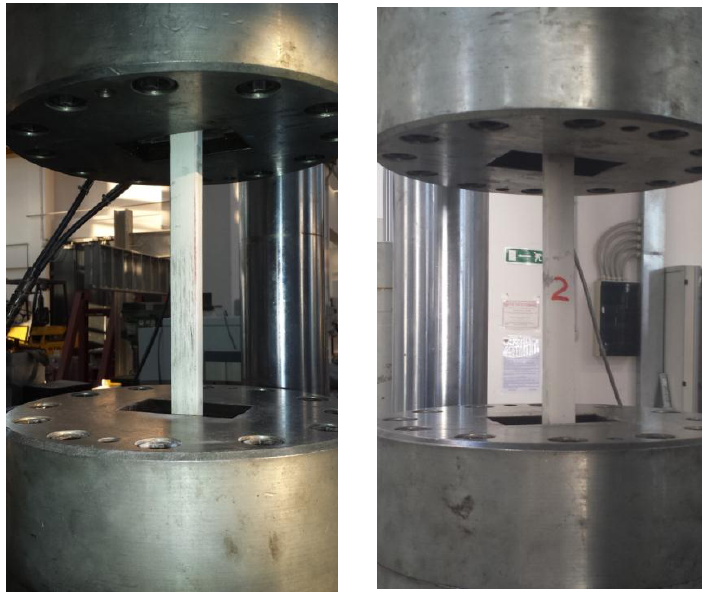
Figure 5. Preliminary tests on GFRP samples: Sample “1” ( left ) and Sample “2” ( right ).